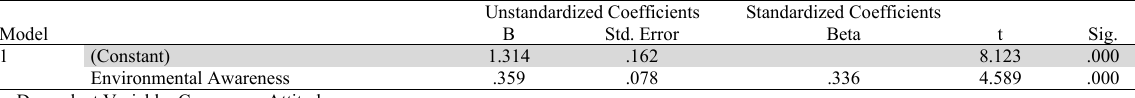
N Mean Std. Deviation